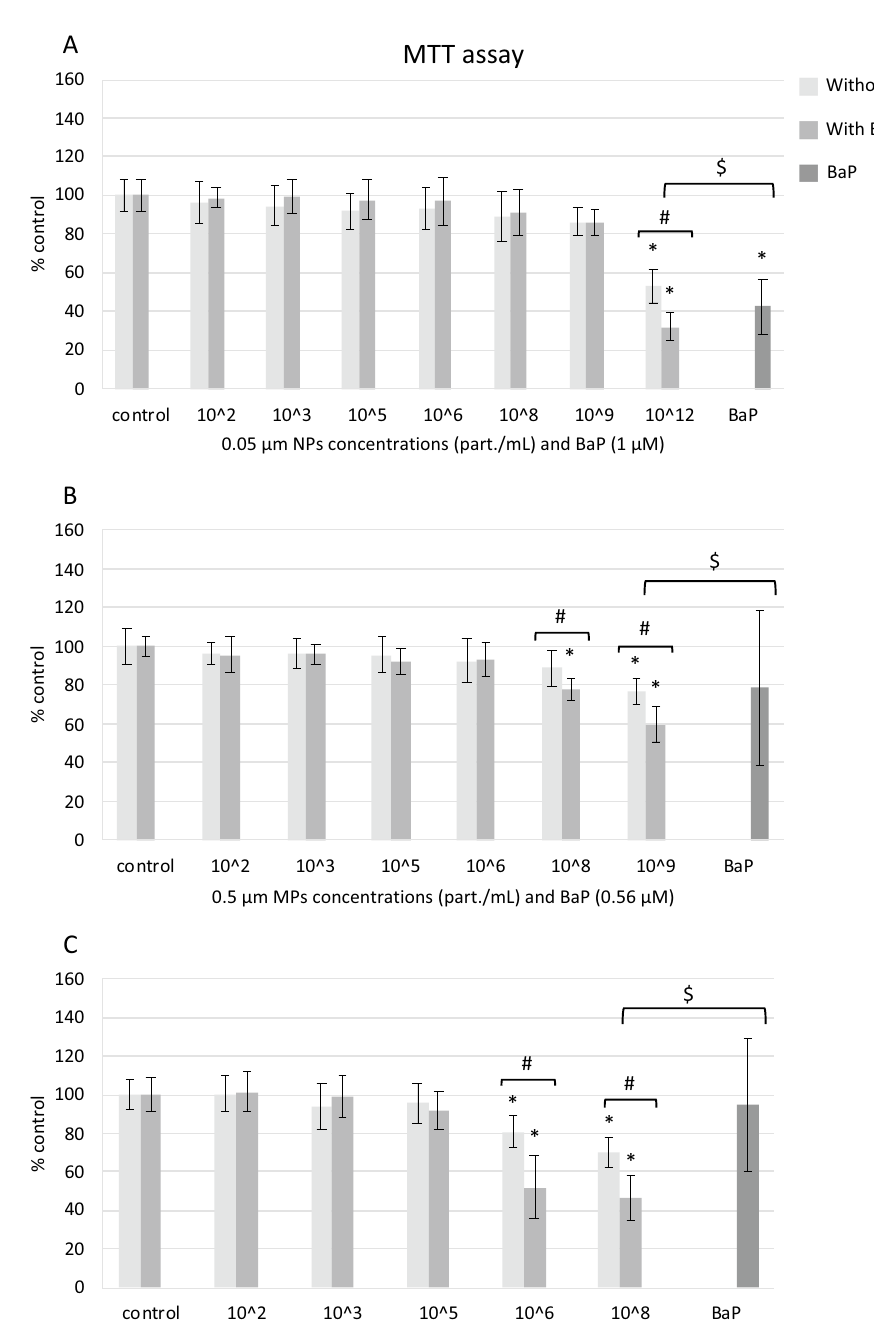
Figure 3. Cell viability (MTT assay) of mussel hemocytes exposed for 24 h to ( A ) 0.05 µm NPs, ( B ) 0.5 µm MPs and ( C ) 4.5 µm MPs alone or in combination with BaP and to BaP alone. Data are given as percentages with respect to control ± SD (n = 18). * indicates significant differences with respect to controls, # indicates significant differences between NPs/MPs with or without BaP and $ indicates significant differences between NPs/MPs with BaP and BaP